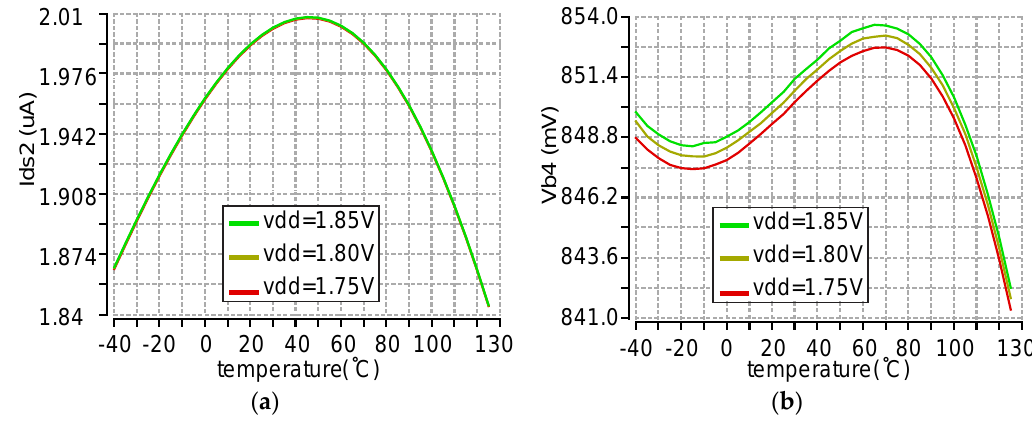
Figure 16. The post layout simulation results of BGR with a temperature range of −40 to 125 °C and vdd range of 1.75–1.85 V. ( a ) The current flow of M2 (1.925 uA ± 81 nA). ( b ) Vb4 (0.85 V ± 3.6 mV).